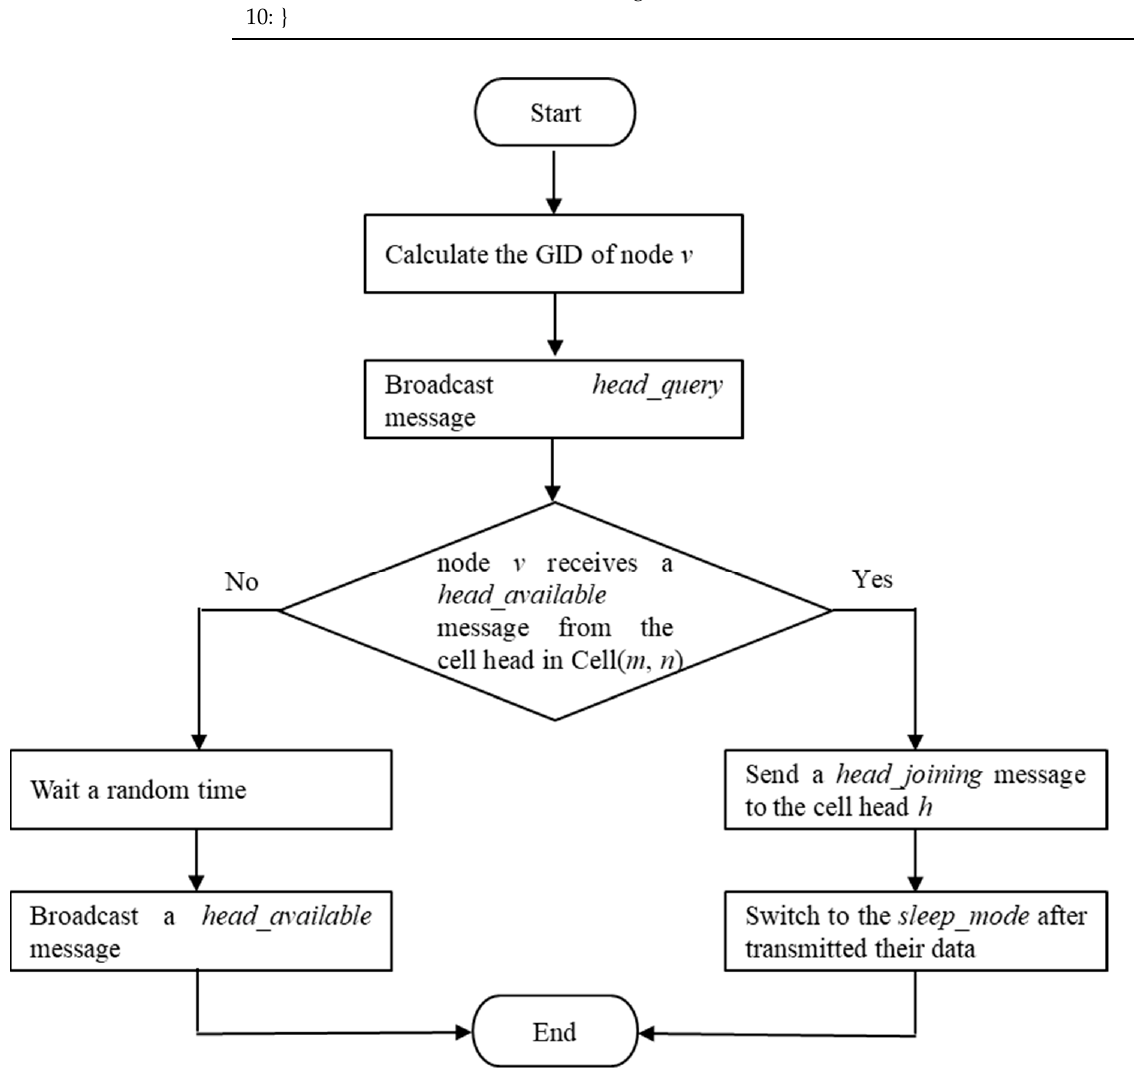
Figure 1. Flowchart of Cell Head Election Algorithm.